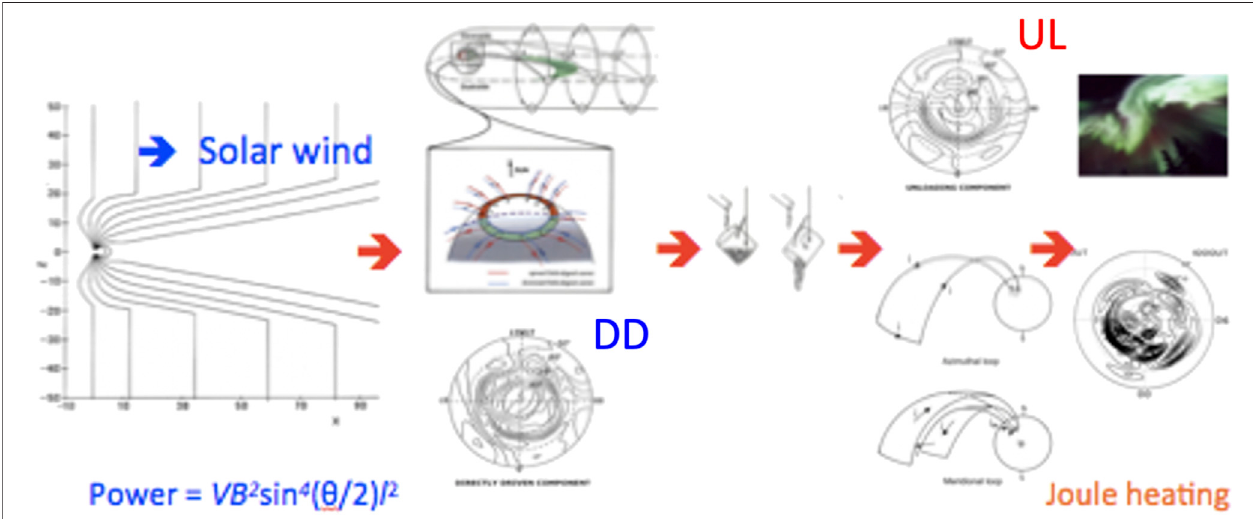
FIGURE10| Theauroralsubstormprocesses,startingfromthesolar-wind-magnetospheredynamo,themagnetosphericcurrentcircuit,theaccumulation-release (unloading) process, the circuit of the expansion phase, and the resulting ionospheric Joule heating (dissipation).